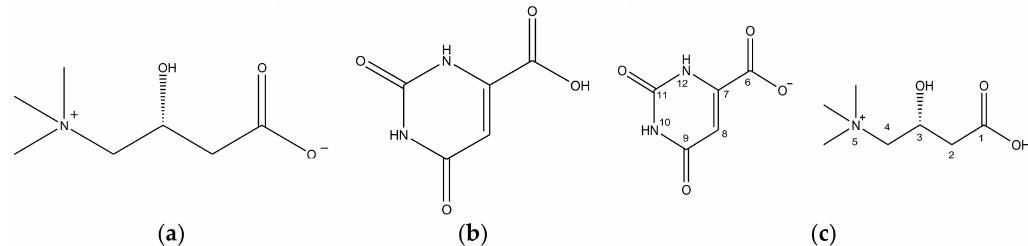
Figure 1. Molecular structure with the atom numbering: ( a ) L -Carnitine ( L -Carn), ( b ) Orotic acid (OA). ( c ) L -Carnitine orotate